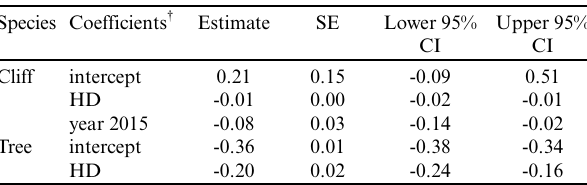
Fig. 1 . Proportion of Barn ( Hirundo rustica ),